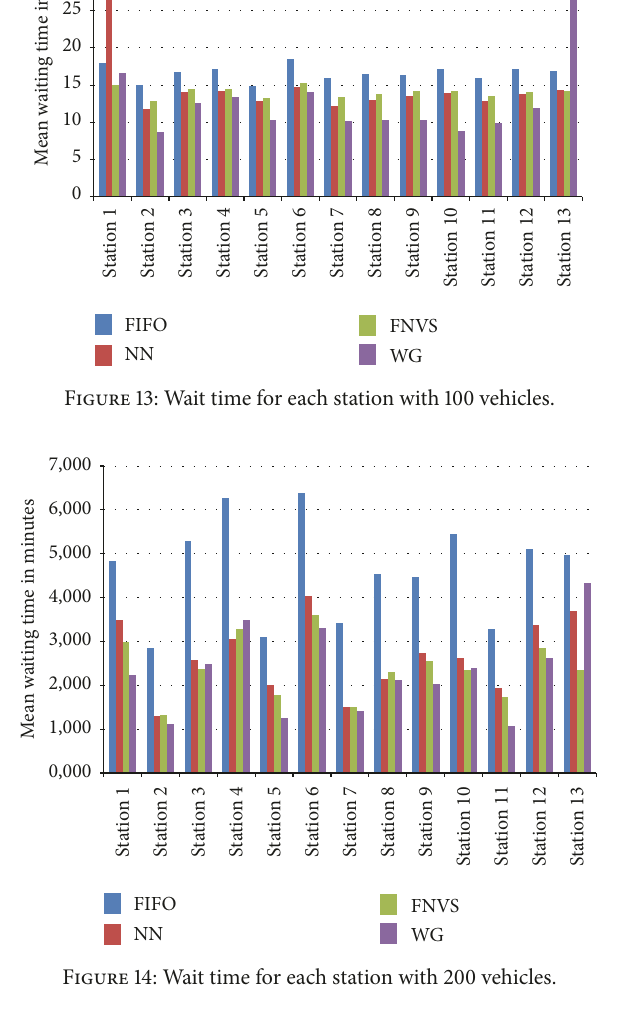
Figure 16: Wait time for each station with 400